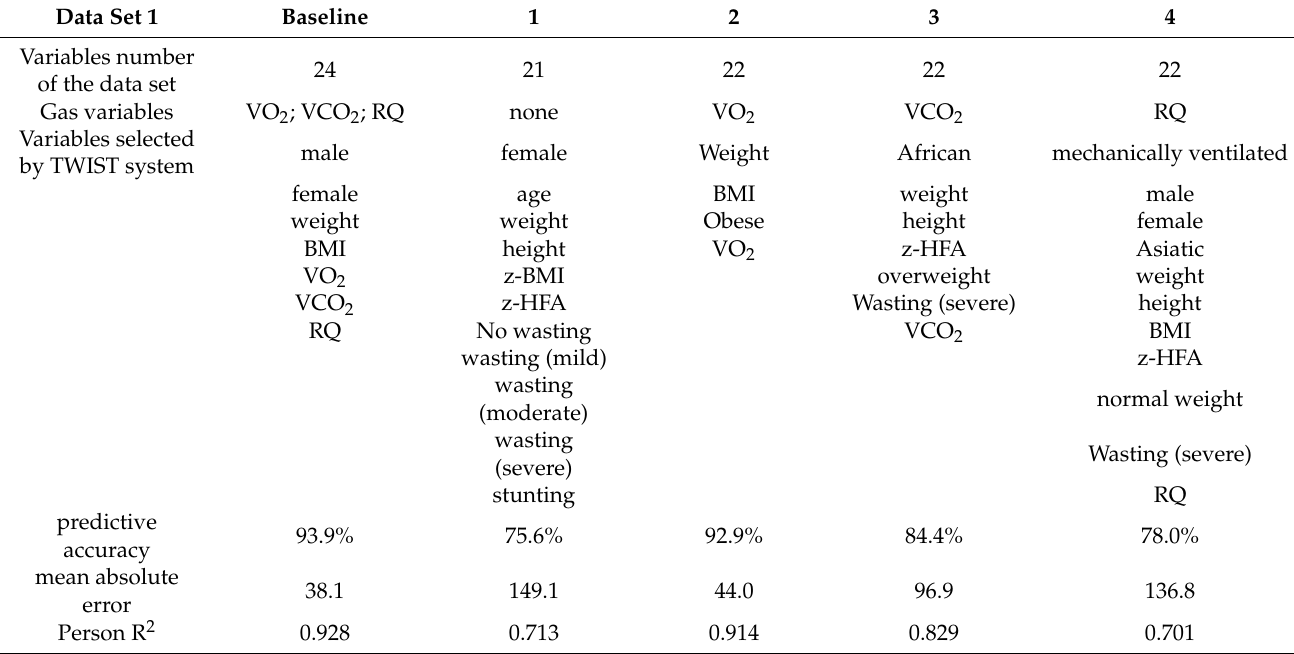
Table 3. Results obtained in the five differential analyses relevant to the role of gas